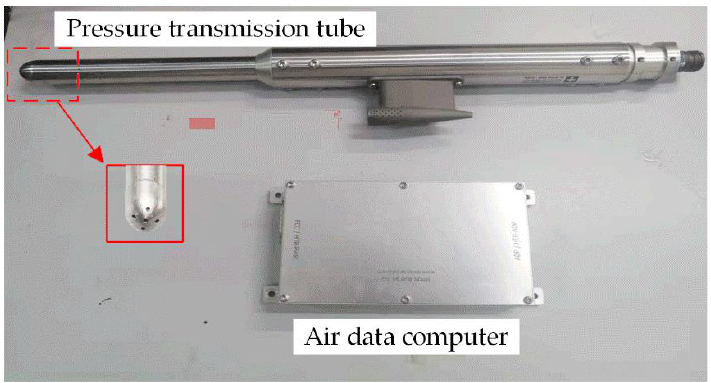
Figure 6. Five-hole probe.